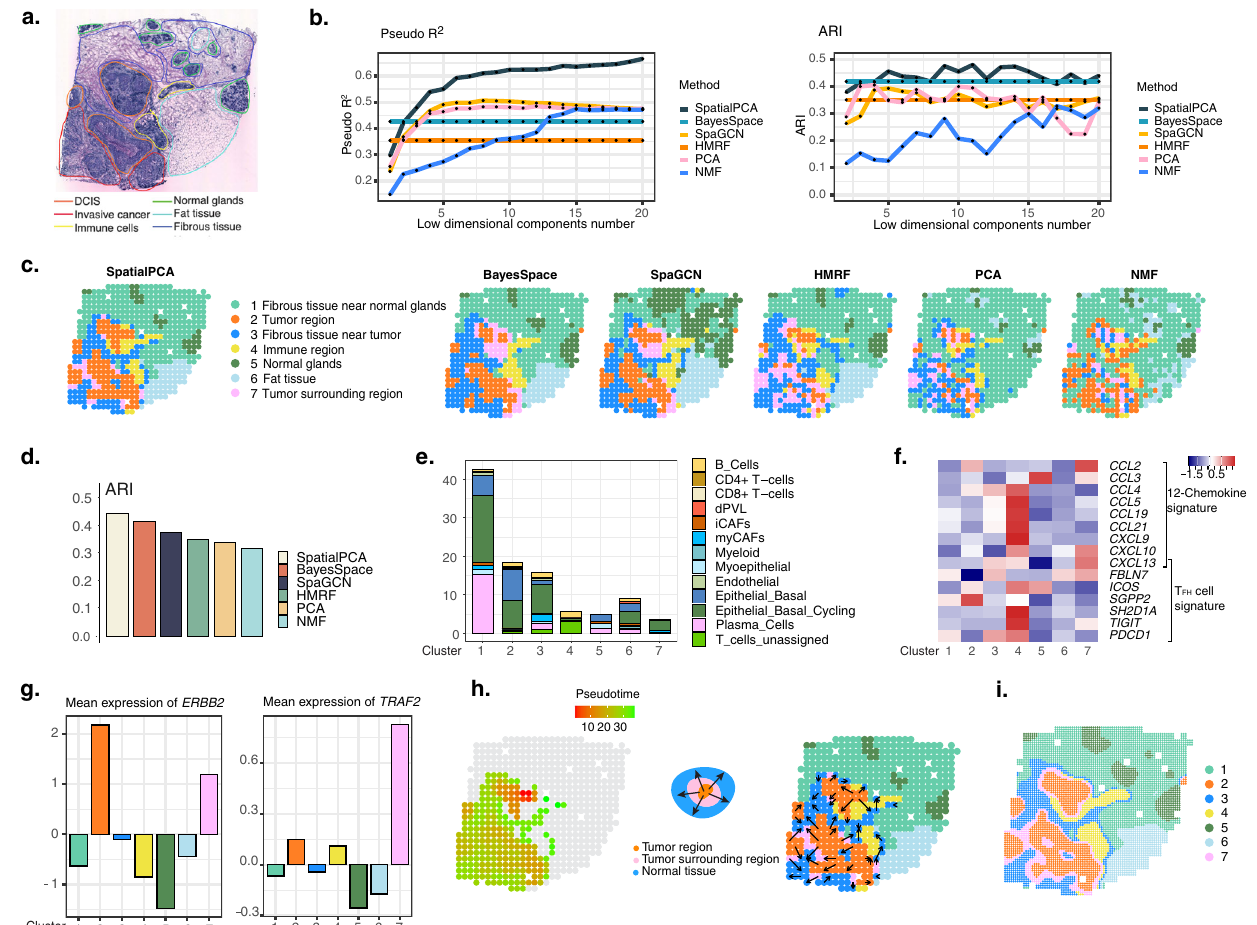
Fig.5|AnalysisoftheHER2tumordatafromST.a Haematoxylinandeosin(H&E) staining image shows distinct tissue regions annotated by a pathologist in the originalstudy.Theannotatedtissueregionsincludeinvasivecancer(red),fattissue (cyan), fi brous tissue (blue), normal breast glands (green), in situ cancer/DCIS (orange), and immune cells (yellow). b Left: spatial PCs in SpatialPCA have higher prediction accuracy in terms of McFadden ’ s pseudo- R 2 (right) for the ground truth labels than latent components in PCA, NMF, and SpaGCN. For BayesSpace and HMRF, we treated their inferred cluster labels as predictors. Right: spatial PCs in SpatialPCA have higher spatial domain clustering accuracy in terms of adjusted Rand index (ARI) for the ground truth labels. c Clustering of tissue locations using differentmethods.Fordimensionreductionmethods(SpatialPCA,PCA,andNMF), clustering was performed based on the inferred low-dimensional components on spatially variable genes. For BayesSpace, SpaGCN, and HMRF, clusters were infer- red directly by the software. d Clustering accuracy of different methods in